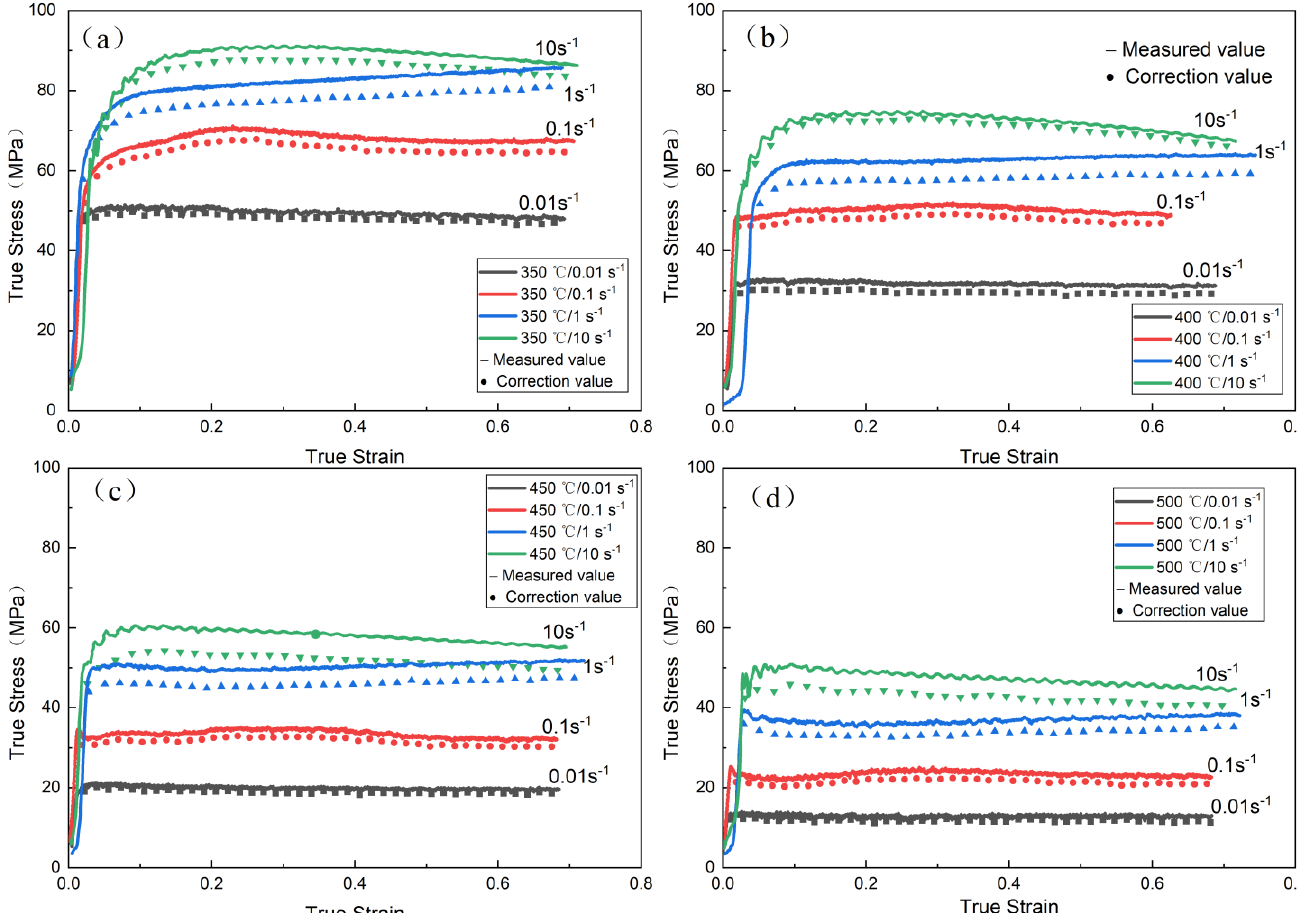
Figure 2. Comparison of true stress-true strain curves before and after drum correction: ( a ) 350 °C; ( b ) 400 °C; ( c ) 450 °C; ( d ) 500 °C.